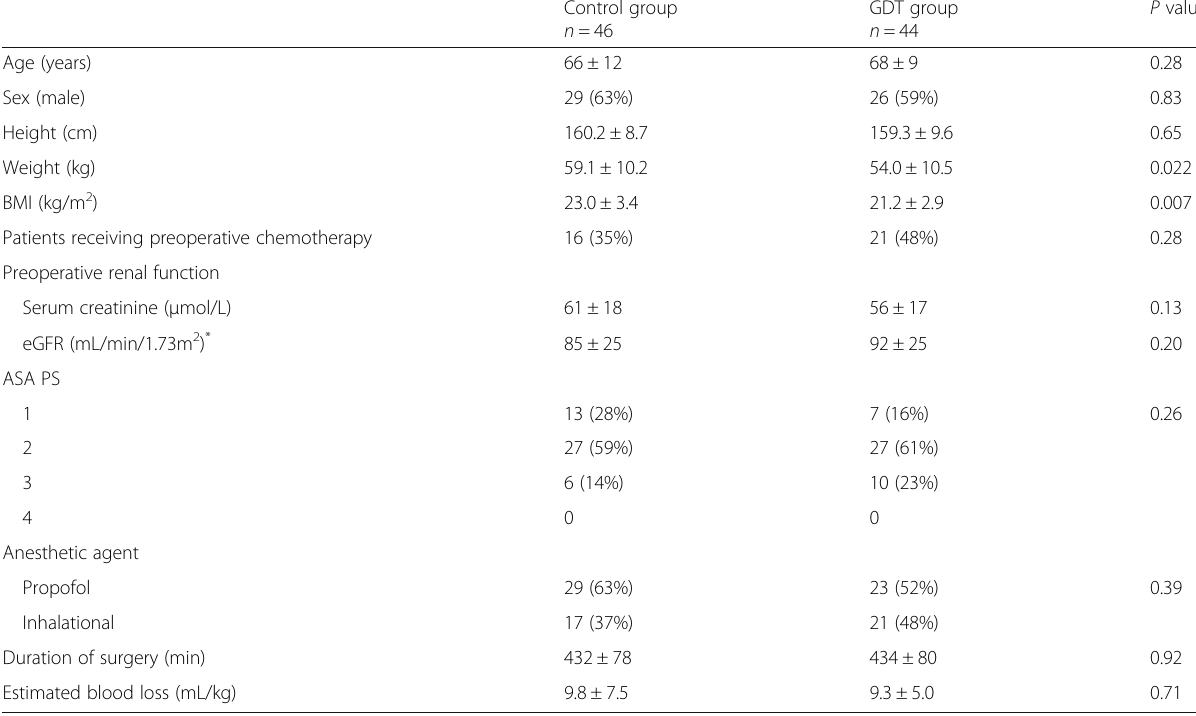
Table 1 Patient demographic characteristics, anesthetic technique, and surgical